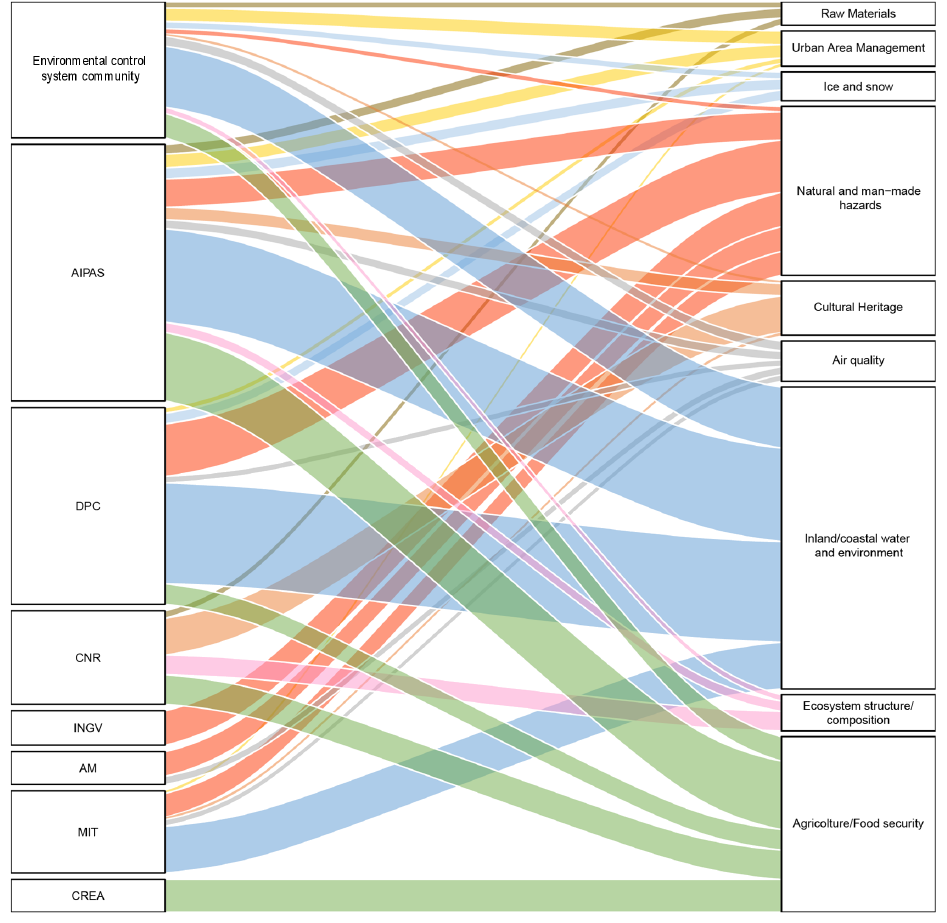
Figure 5. Sankey diagram representing the preference of each user community (left side entities) for the considered thematic areas (right side entities). The thickness of each connecting line is determined as a function of the (averaged) priority values assigned by each user community to the requirements identified for each thematic area (represented by a different color).